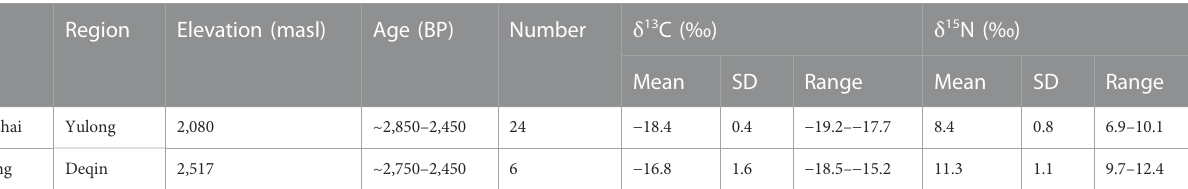
TABLE 2 Summary of human isotopic values from the Gaozhai and Adong